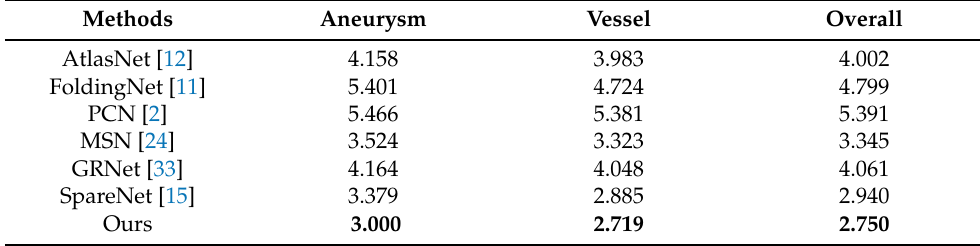
Table 3. Point completion results on IntrACompletion in EMD × 10 3 (lower is